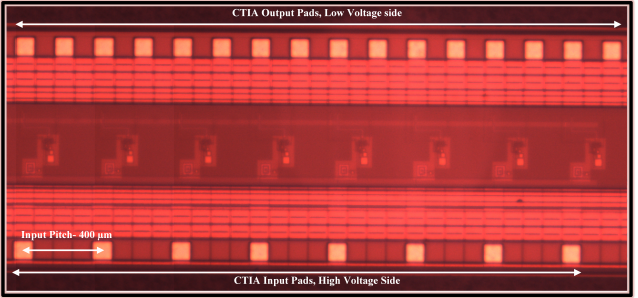
Figure 6. Chip photomicrograph: Eight CTIA unit cells can be identified with their input pads on the bottom side and output pads on the top.